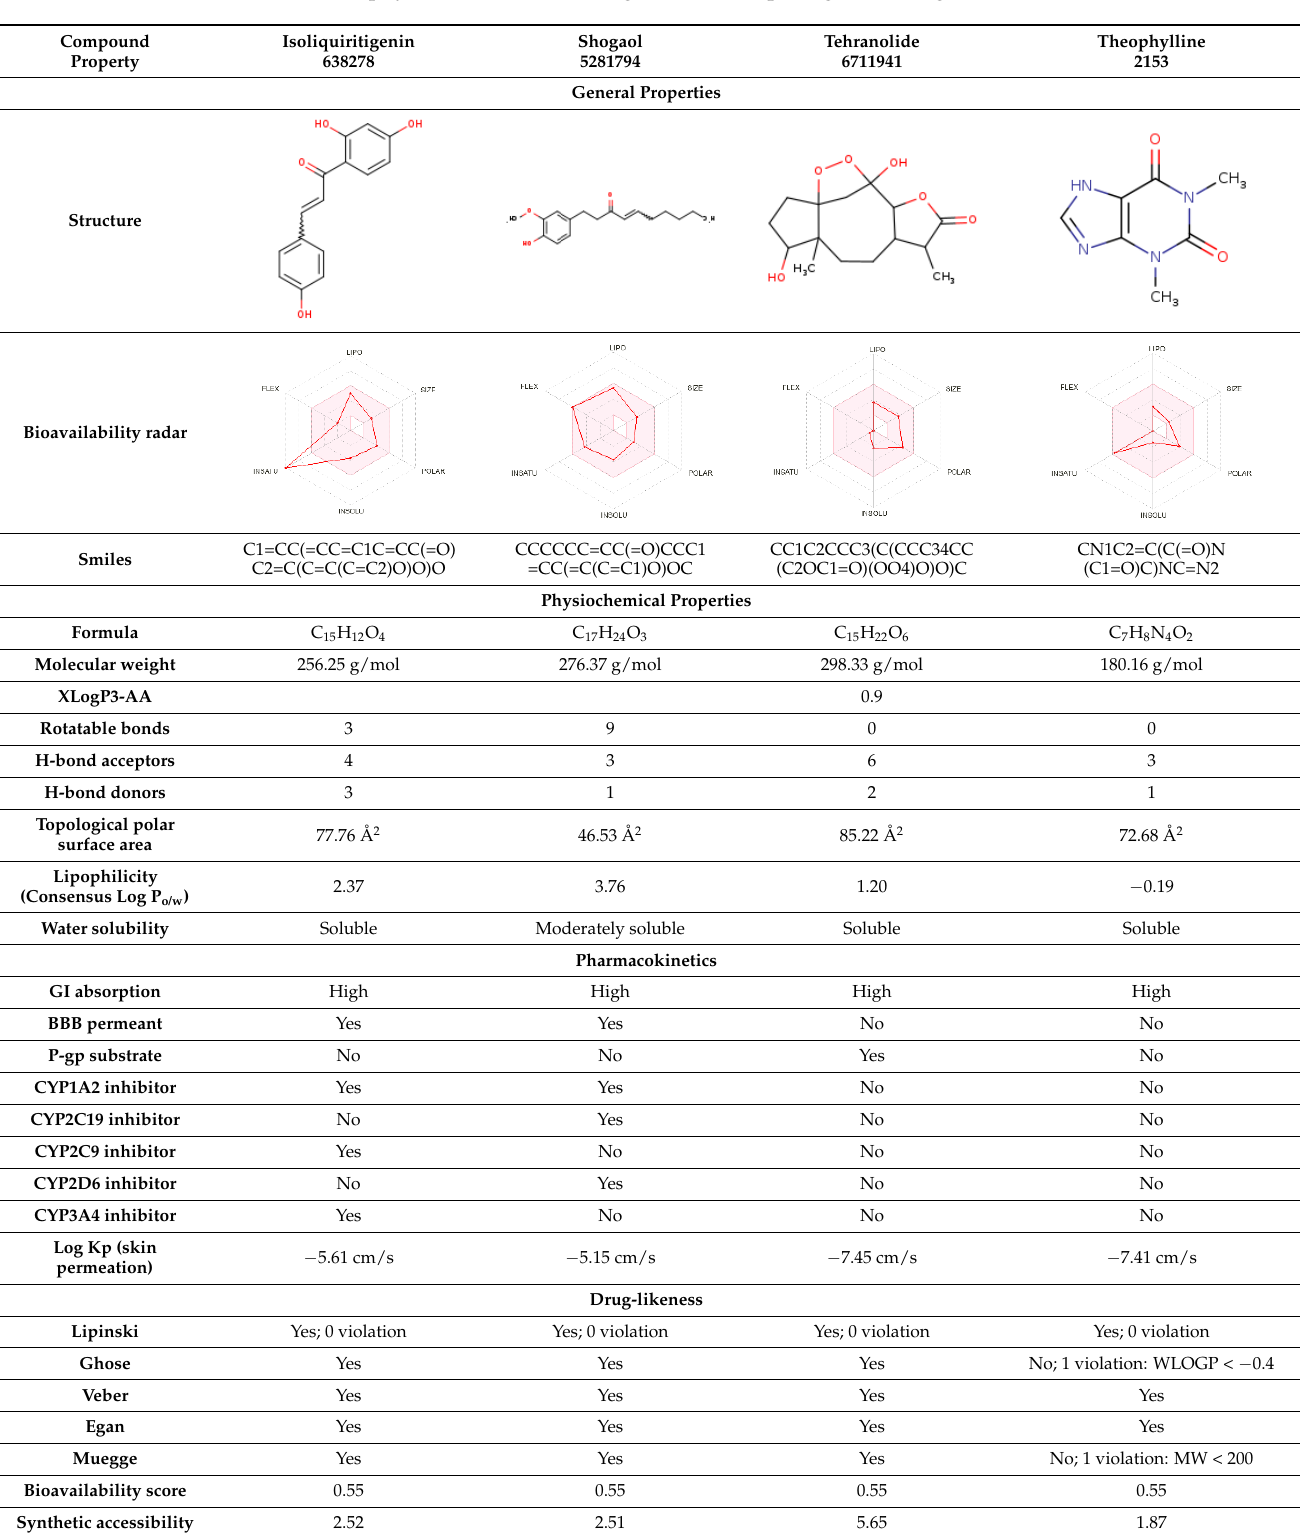
Table 3. Computed physical, chemical, pharmacokinetics, and drug-likeness properties of ligands (theophylline, tehranolide, shogaol, and isoliquiritigenin) using SwissADME. Compound